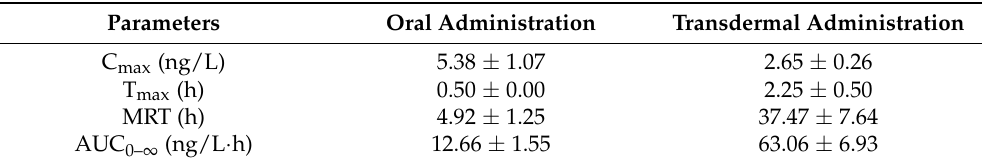
Table 5. Pharmacokinetic parameters of colchicine in plasma following transdermal (6.4 mg/kg) and oral (0.6 mg/kg) administration in rats (mean ± SD, n = 6).